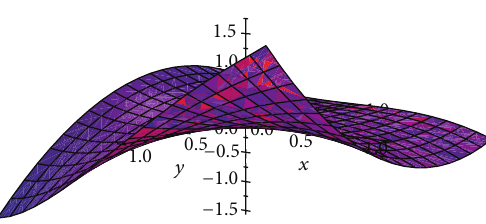
Figure 4: Approximate two-term approximation for Example